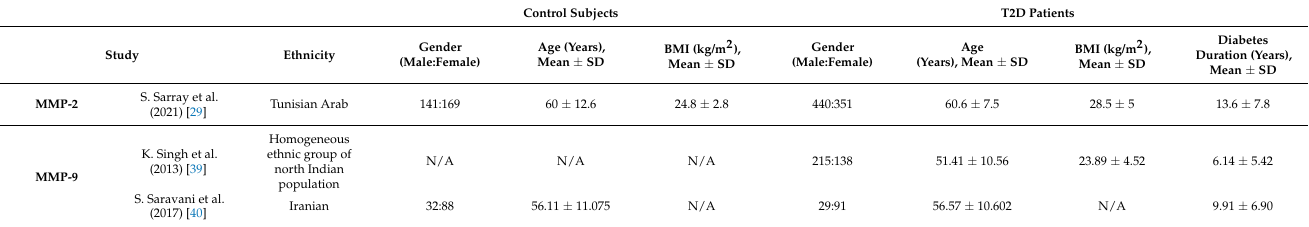
Table 3. Characteristics of control groups and patients with type 2 diabetes.